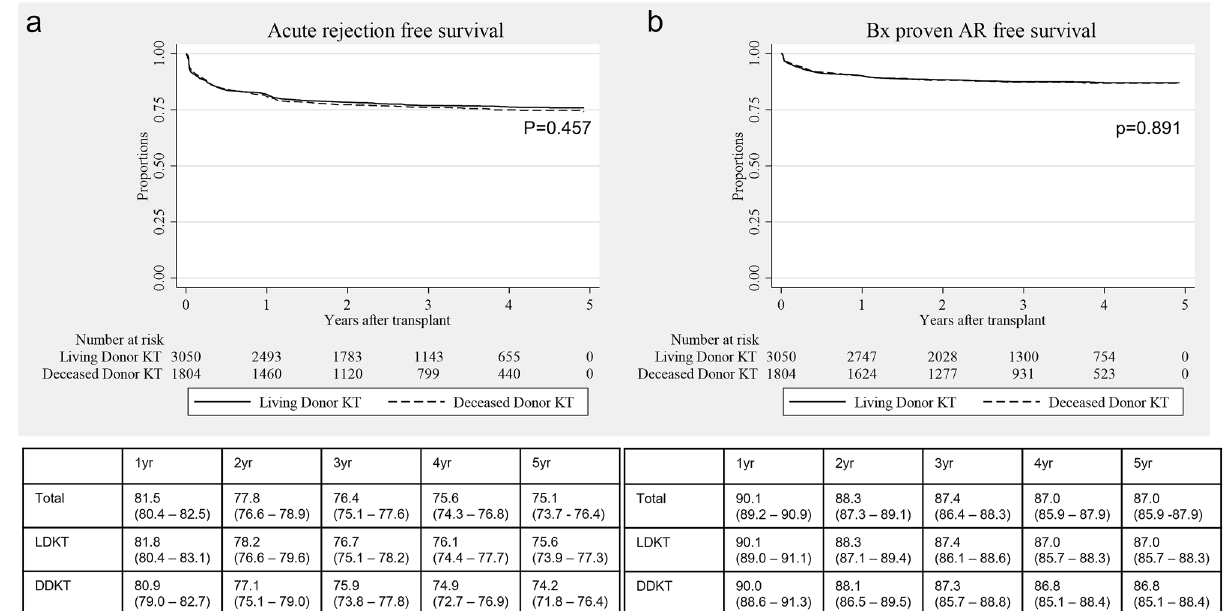
Figure 2. Acute rejection free- ( a ) and biopsy-proven acute rejection free- ( b ) survival of Korean Organ Transplantation